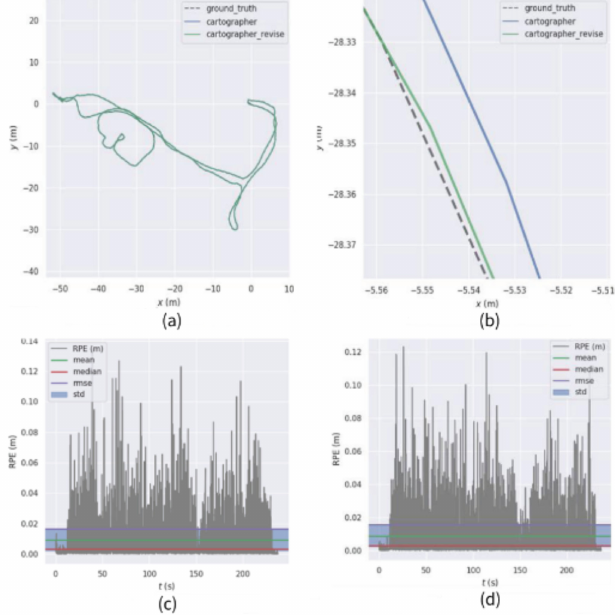
Figure 10. Comparison of relative trajectory errors of sequence 3 (cid:13) . ( a ) Cartographer, improvement scheme, and real trajectory comparison ( b ) Local trajectory map ( c ) Absolute trajectory error of Cartographer ( d ) Absolute trajectory error of the improved